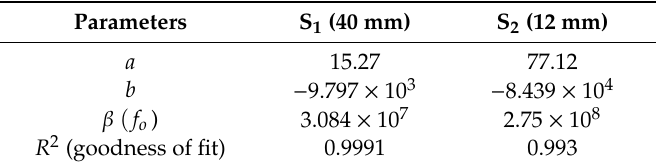
Figure 16. Nonlinear model fitting for a pressure range of 0 to 300 mmHg: ( a ) Measured response (dotted) and linear fit (solid) of S 1 ; ( b ) Measured response (dotted) and linear fit (solid) of S 2 . Table 3. Coe ffi cients of 2nd order polynomial ( f ( P ) = a × P 2 + b × P + β ; where P is pressure) curve fitting between measured resonance frequencies and applied pressure.